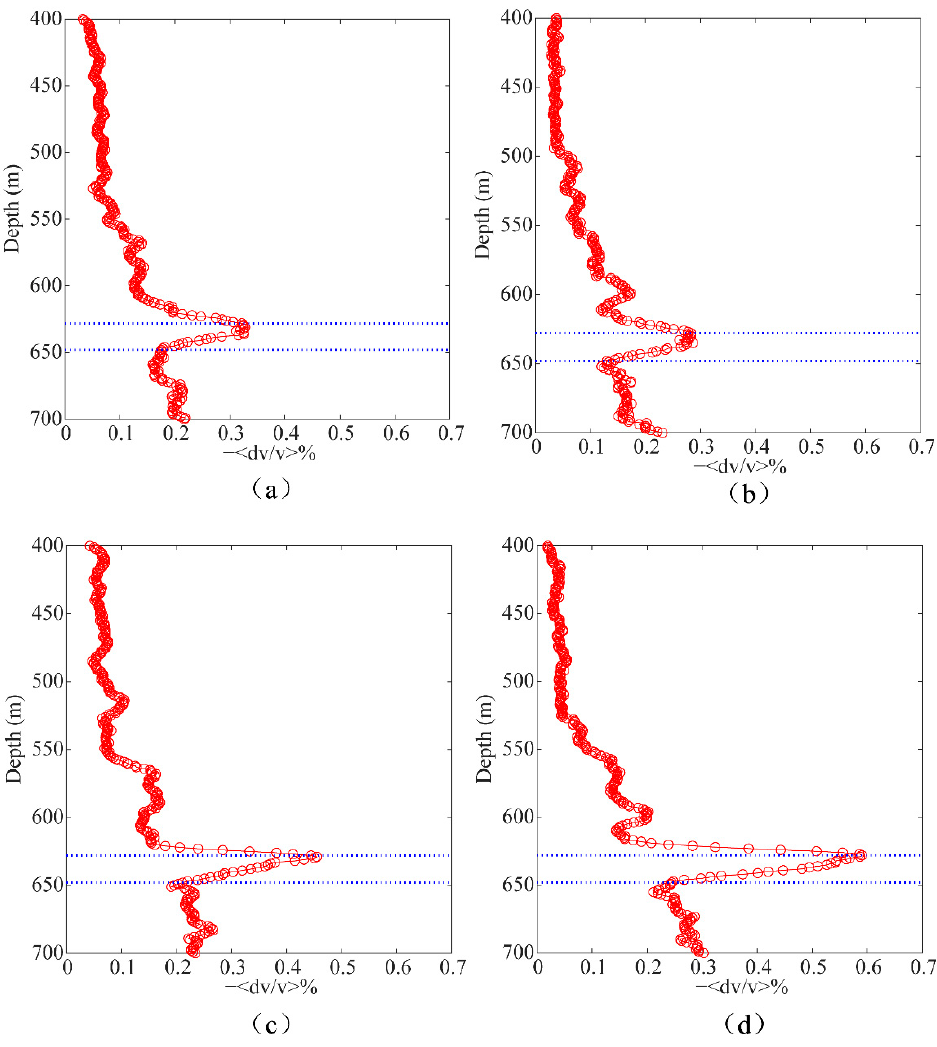
Figure 8. The estimated mean velocity change versus the receiver depth from the baseline survey and first-repeat survey using ( a ) CWI processing of the upgoing P waves of the vertical component obtained via wavefield separation, ( b ) CWI processing of the upgoing PS waves of the horizontal component obtained via wavefield separation, ( c ) CWI processing of the upgoing waves of the vertical component, and ( d ) CWI processing of the upgoing waves of the horizontal component. The CO 2 injection layer is indicated by blue dotted lines.